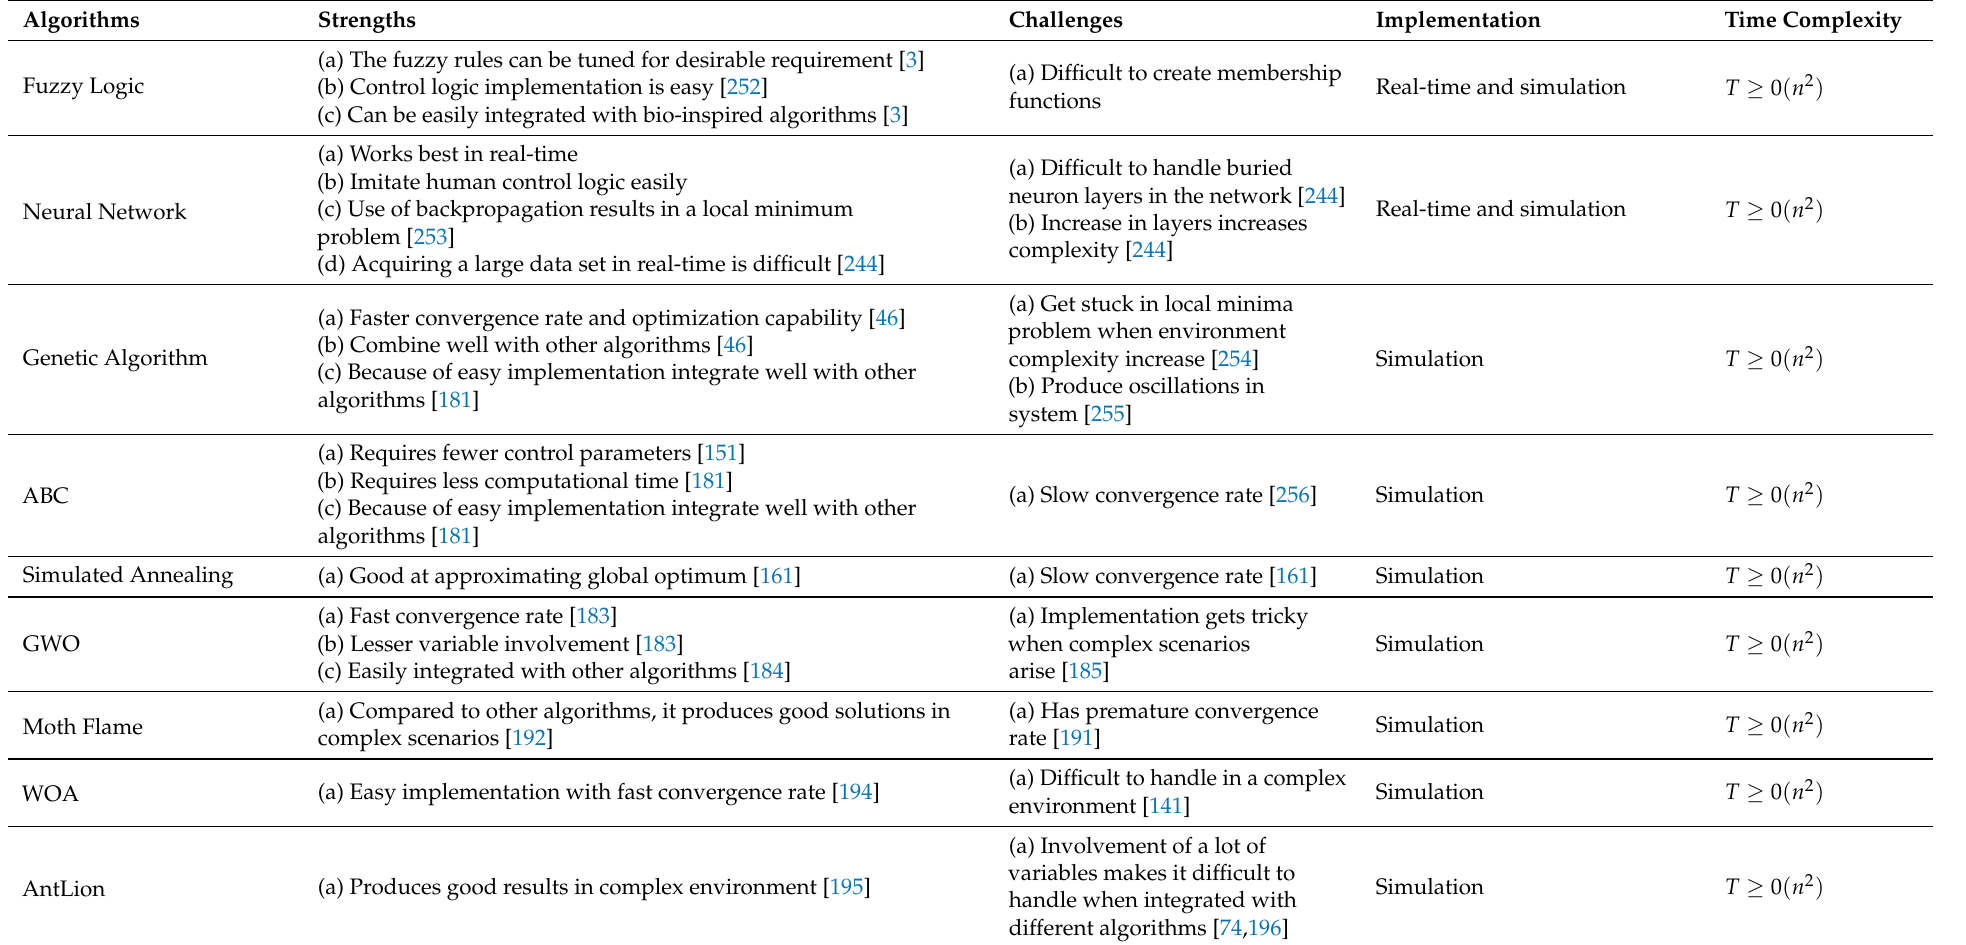
Table 9. Strengths and Challenges Involved in Hybrid Methods for Ground & Aerial